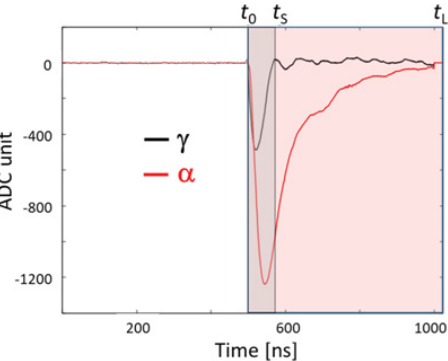
Figure 4. Examples of signals delivered by the MPPC. The red line corresponds to a typical signal produced by an α particle while the black one refers to a typical signal from γ background. The times t 0 , t S , t L are defined in Eq. (8).